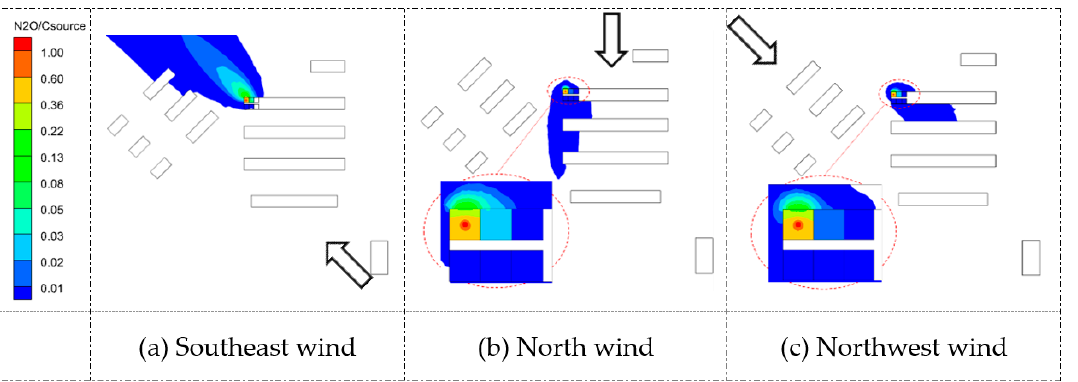
Figure 10. Comparisons of nondimensional concentration fields on horizontal plane Z = 0.76 m under three wind directions for D3 source building. Arrows represent three different wind directions.